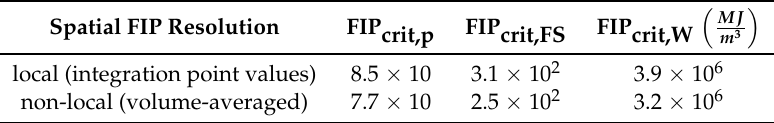
Table 6. Local and non-local critical fatigue indicator parameters for SAE